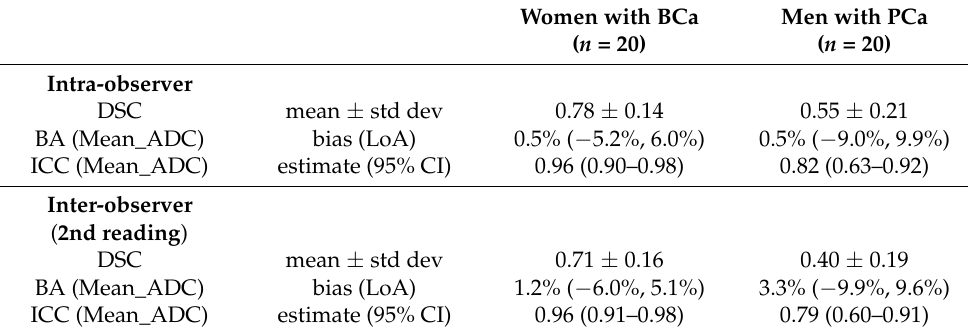
Table 3. Summary of observer-dependent reproducibility metrics.